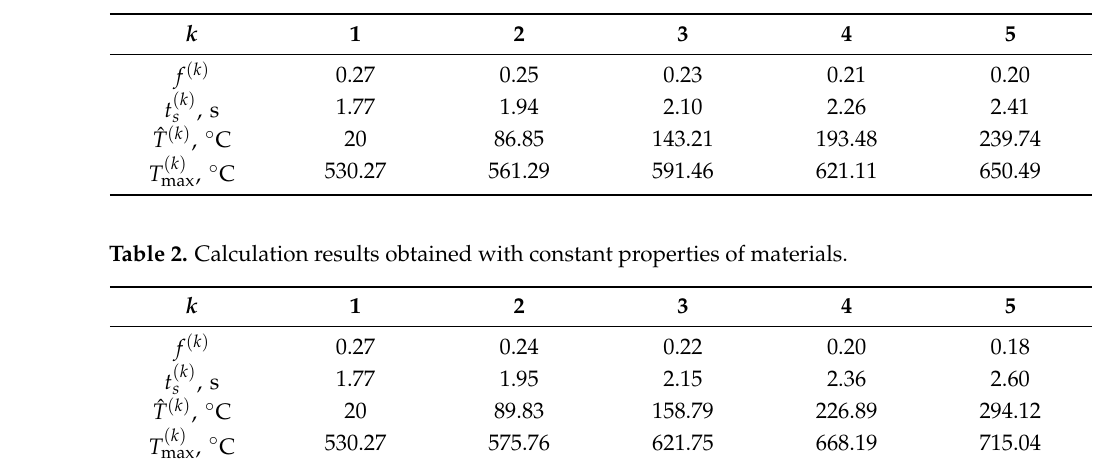
Figure 4. Evolutions of temperature on the friction surface during each of the five braking actions with (solid lines) and without (dotted lines) taking into account the thermal sensitivity of materials. Table 1. Calculation results obtained with consideration of the materials’ thermal sensitivity.